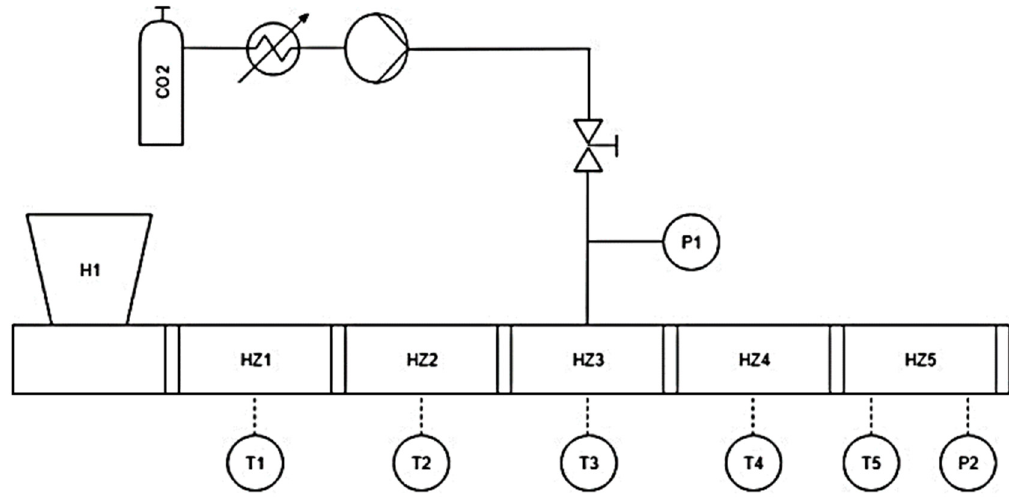
Figure 1. Schematic picture of the twin extruder.